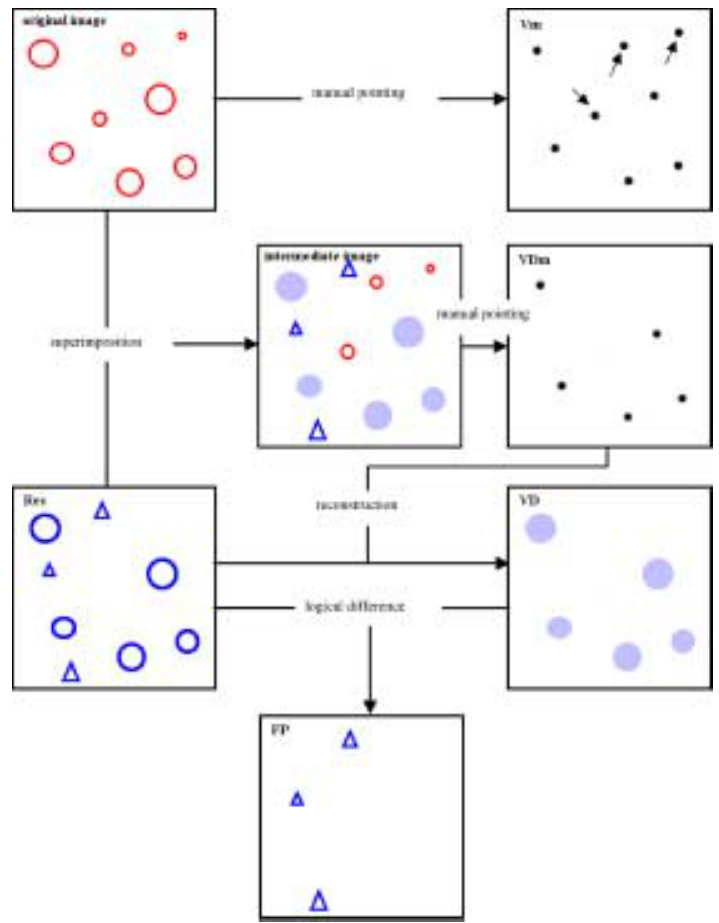
Fig. 2. Principle of the quality control procedure. The true colour original image contains structures of interest of different sizes (circles); a manual pointing of these objects gave the reference mask (Vm). The automatic procedure (binary image Res) detected some of them (cir- cles), and isolated false-positive structures (triangles). The intermediate image shows well-detected objects (full circles), not detected objects (empty circles) and false-positive structures (triangles). A manual pointing of only well-detected objects gave a mask of these structures (VDm). From this mask, structures of Res were reconstructed, given rise to a binary image of these well-detected objects (VD). A logical differ- ence between Res and VD resulted in a binary image of false-positive structures (FP). Object number within Res, VD and FP were com- puted and percentages of well-detected and false-positive structures were calculated as described in methods. This figure can be viewed on